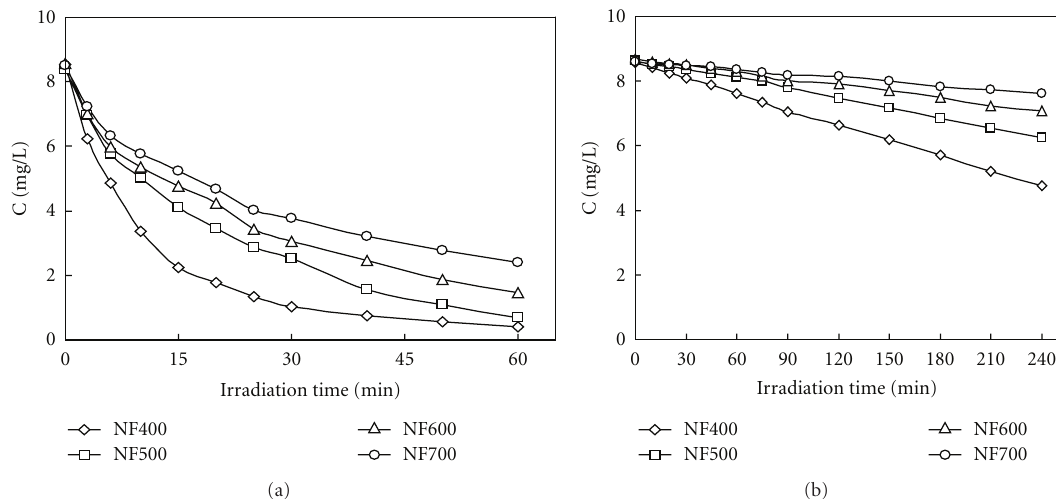
Figure 8: Photocatalytic degradation of p-nitrophenol (PNP) using NF400, NF500, NF600, and NF700 as catalysts under (a) ultraviolet and (b) sunlight.